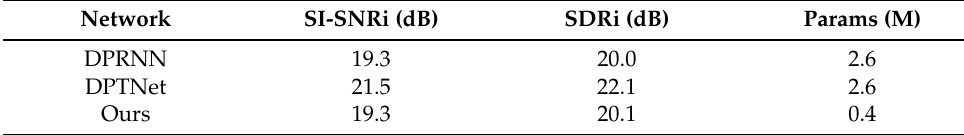
Figure 8. Separation results. ( a ) represents the spectrogram of mixed species bird sound, ( b , c ) repre- sents the bird sound separated from ( a ). ( d ) represents the mixed species bird sound after mixing the noise, and ( e , f ) represents the bird sound separated from ( d ). ( g , h ) are clean original bird sounds. Table 2. Separation performance of different network on the bird sounds